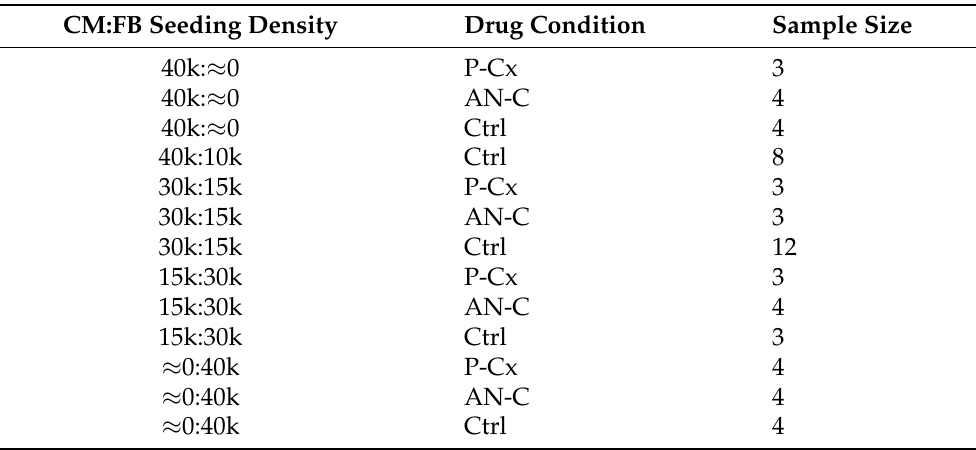
Figure A2. Western blot of three different experimental runs (Samples 1, 2, and 3) showing expression of each protein with (Drug) and without drugs (Ctrl). Each junction protein was run on a separate gel with three samples from different experimental runs on each gel. Table A1. Details of each seeding